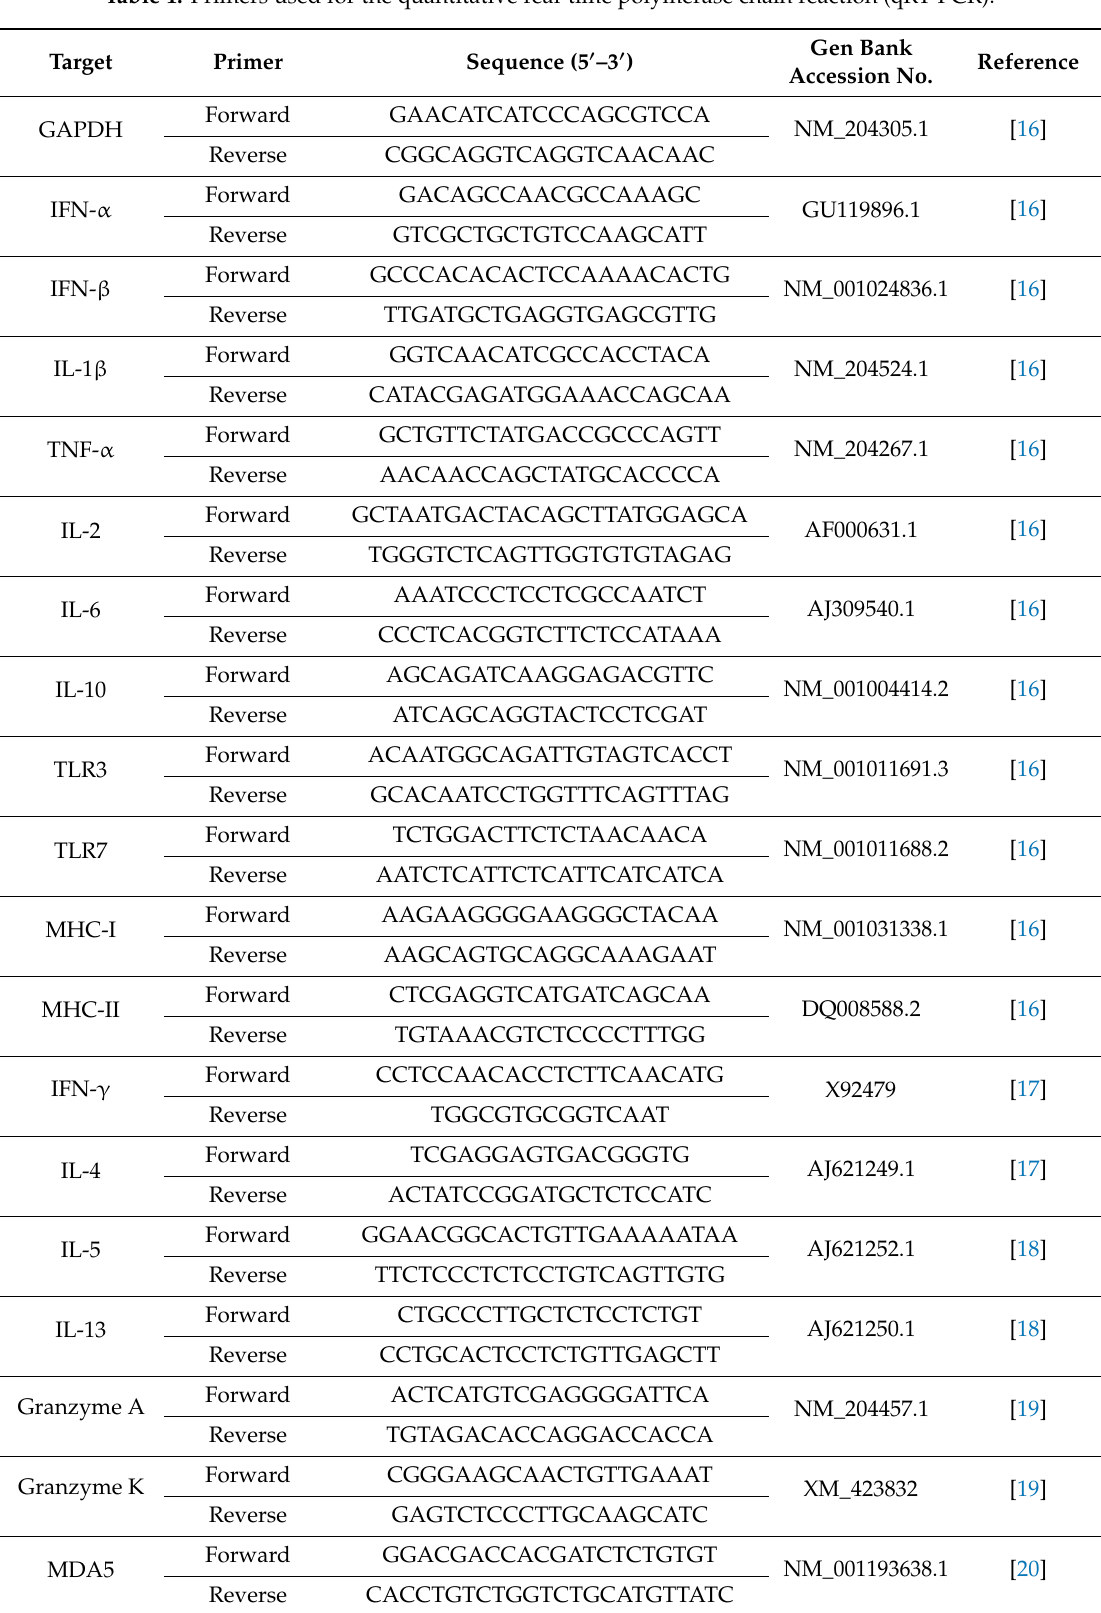
Table 1. Primers used for the quantitative real-time polymerase chain reaction